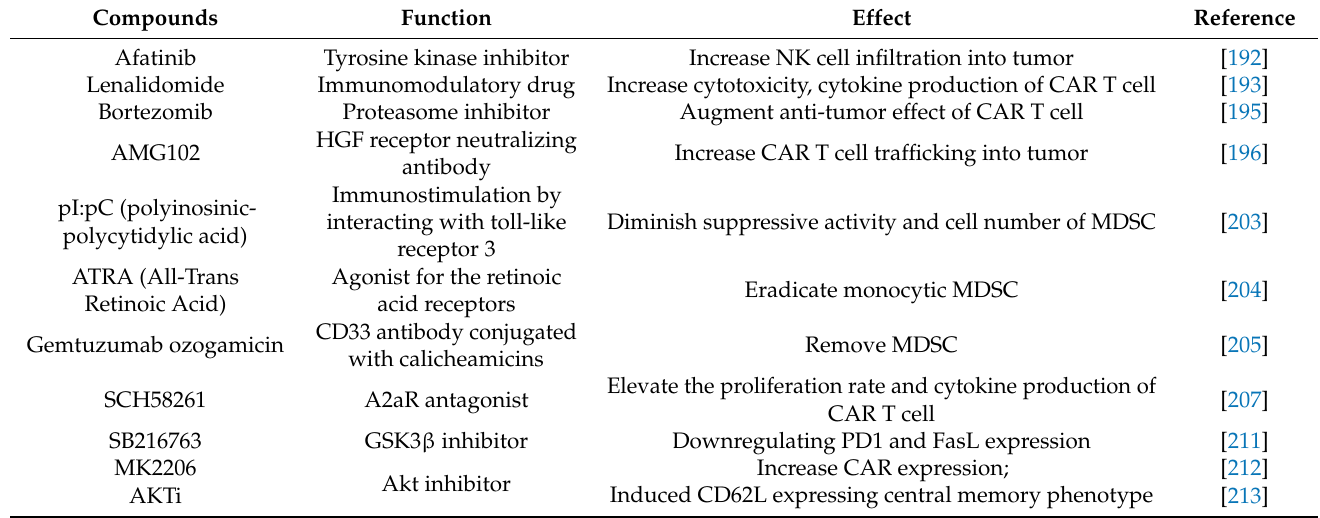
Table 2. Compounds enhancing CAR T cell